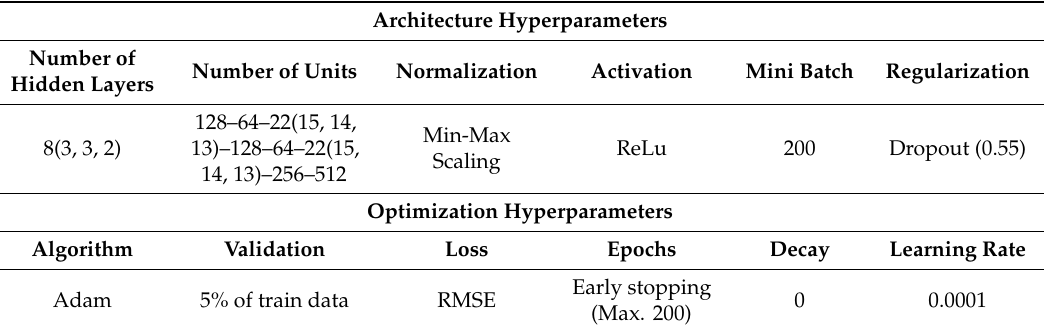
Table 3. Hyperparameters for deep-stacked convolutional bidirectional LSTM